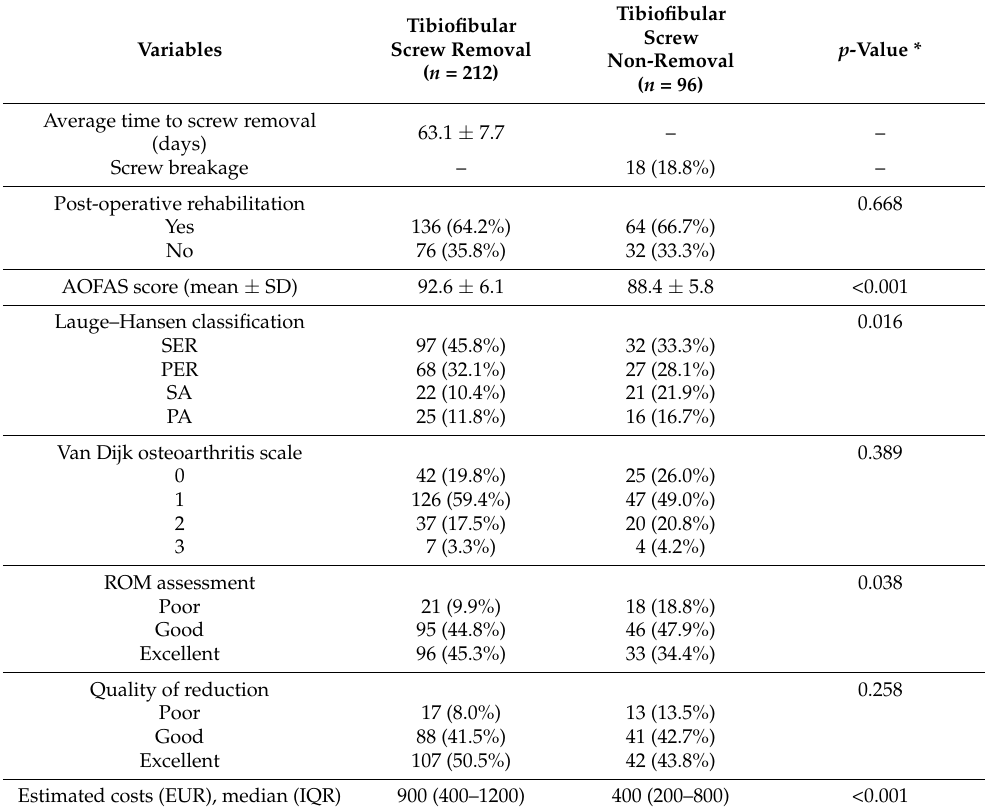
Table 3. Patient follow-up at six months after the initial surgery.